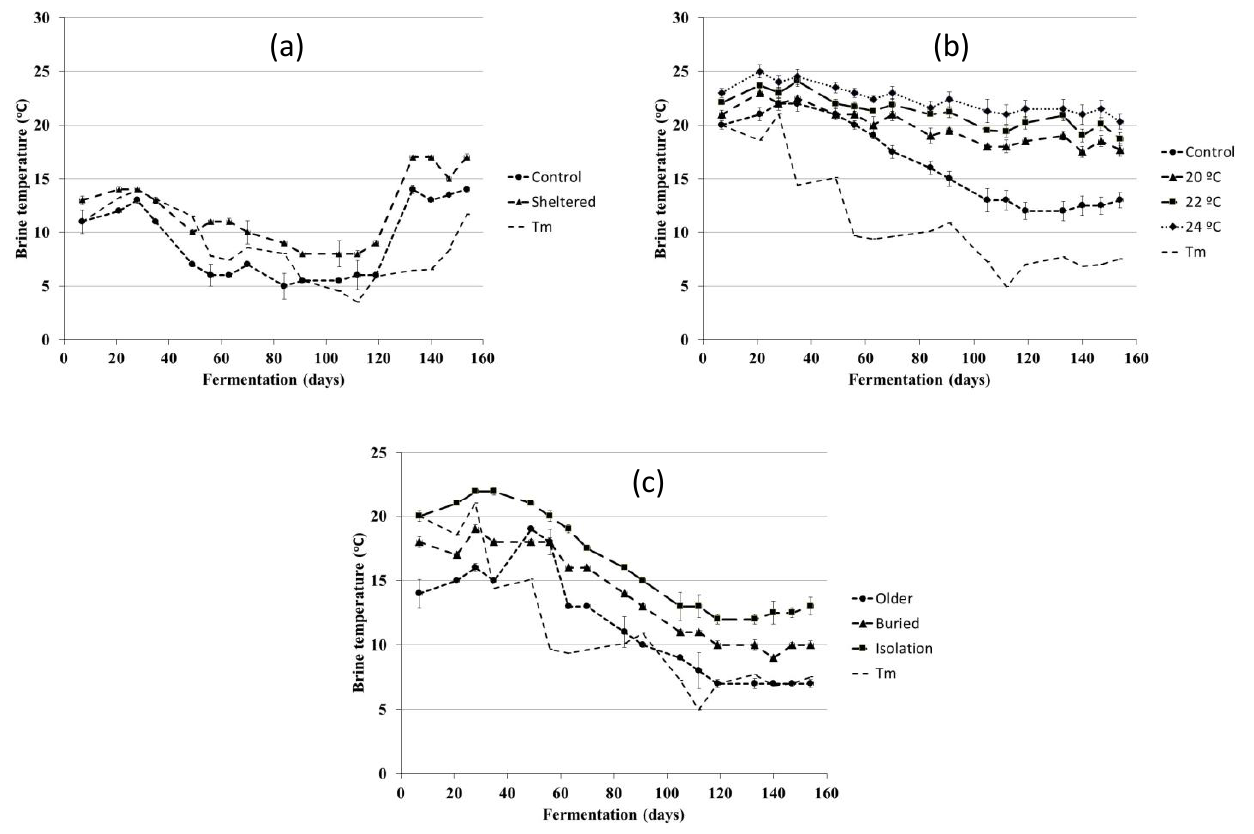
Figure 1. Brine temperature measured in each of the tanks during the fermentation process. Each figure also presents average ambient temperature (Tm) as recorded by the closest weather station. Experiment 1 ( a ), experiment 2 ( b ), experiment ( c ).